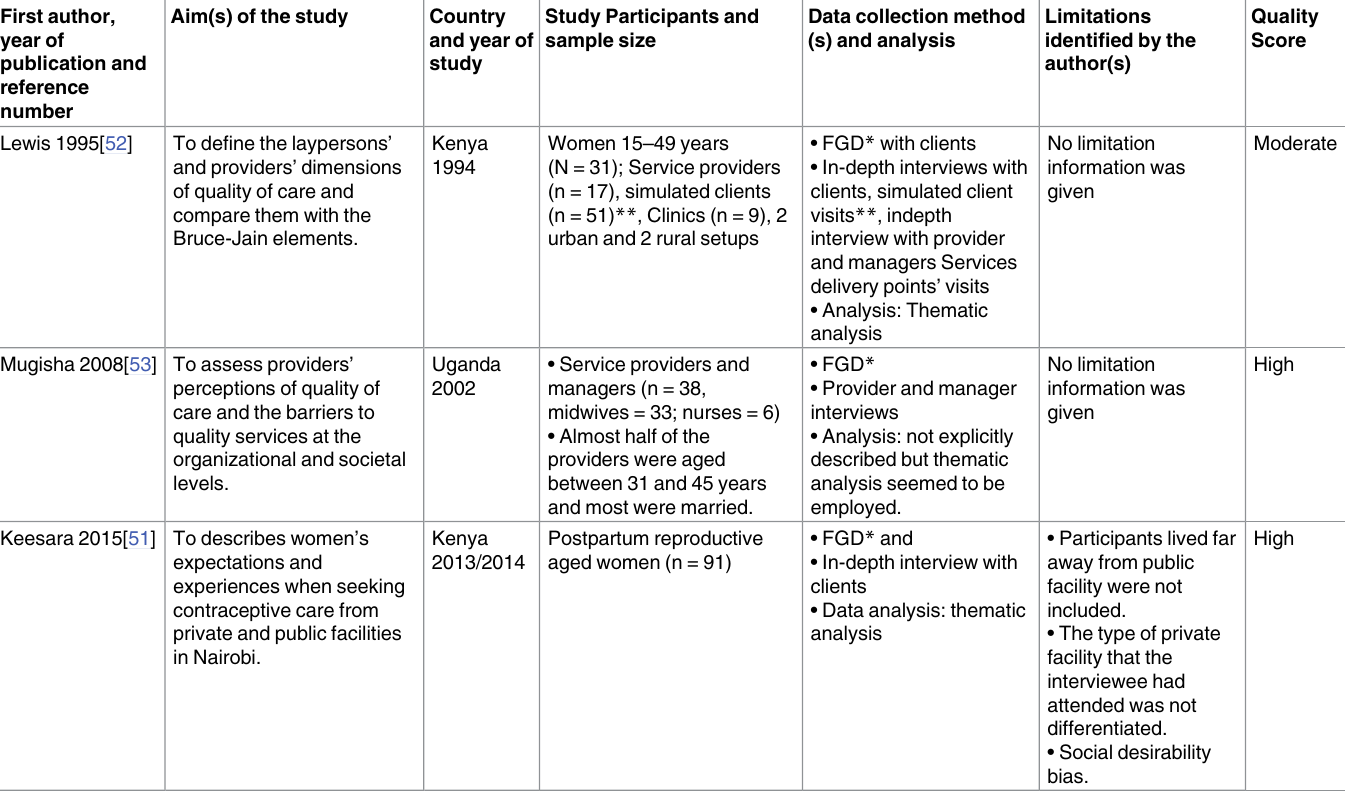
Table 2. Key characteristics of qualitative studies included in the